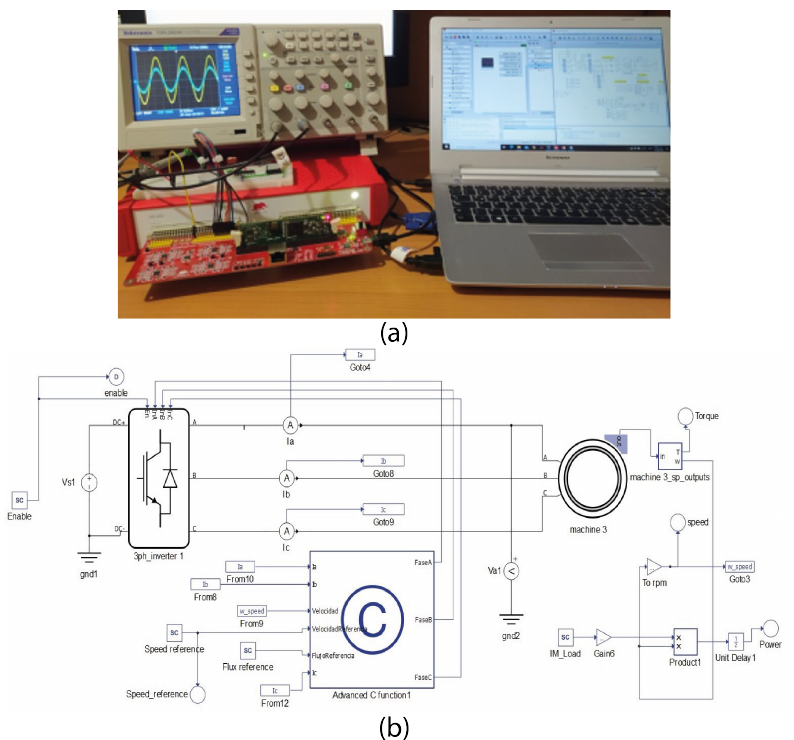
Figure 7. Interface DSP: ( a ) DSP 100 and Typhoon HIL 402; and ( b ) Typhoon HIL schematic